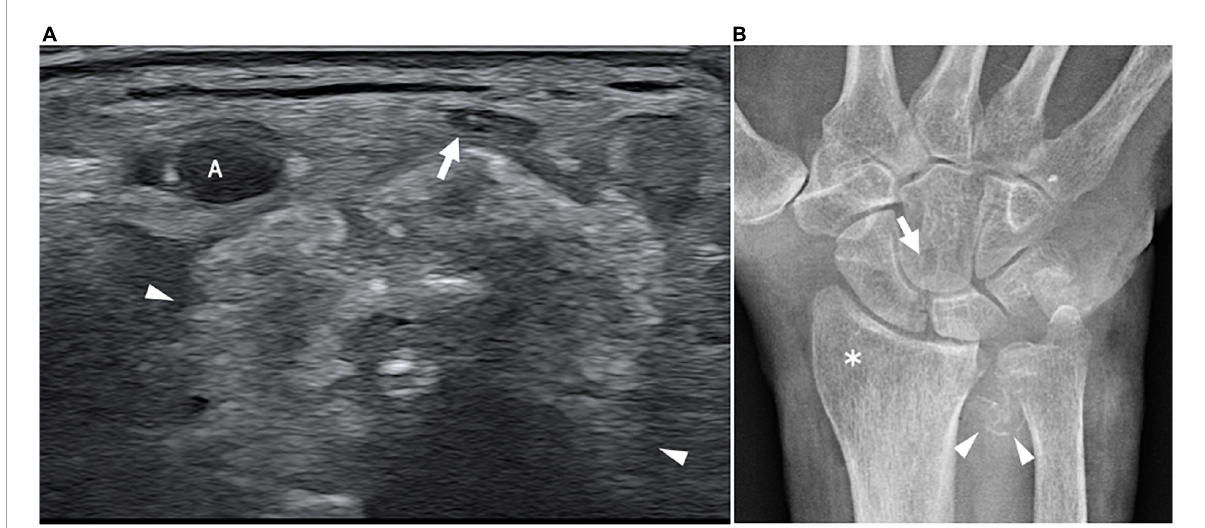
FIGURE7 This figure shows an axial 18 MHz HRUS image of the wrist (A) and an antero-posterior X-ray image of the wrist in a 68 years old female affected by systemic sclerosis and monolateral carpal tunnel syndrome. (A) The distal radio-ulnar joint recess is distended by hyperechoic amorphous material partially calcified (white arrowheads) which compresses and superficially dislocates the median nerve (white arrow). (B) The X-ray confirms the presence of calcification (white arrowheads) in correspondence to the soft tissue in proximity to the distal radio-ulnar joint. Para-articular osteoporosis (white asterisk) and erosions (white arrow) at the level of the carpal bones are also observed. A, radial